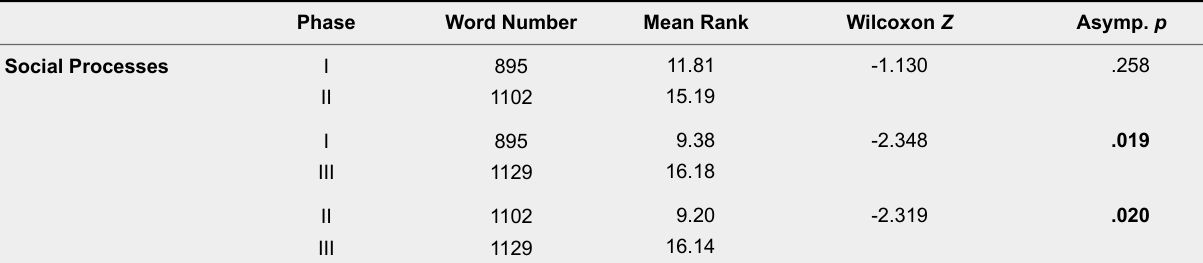
Wilcoxon Test for the Relational Dimension of